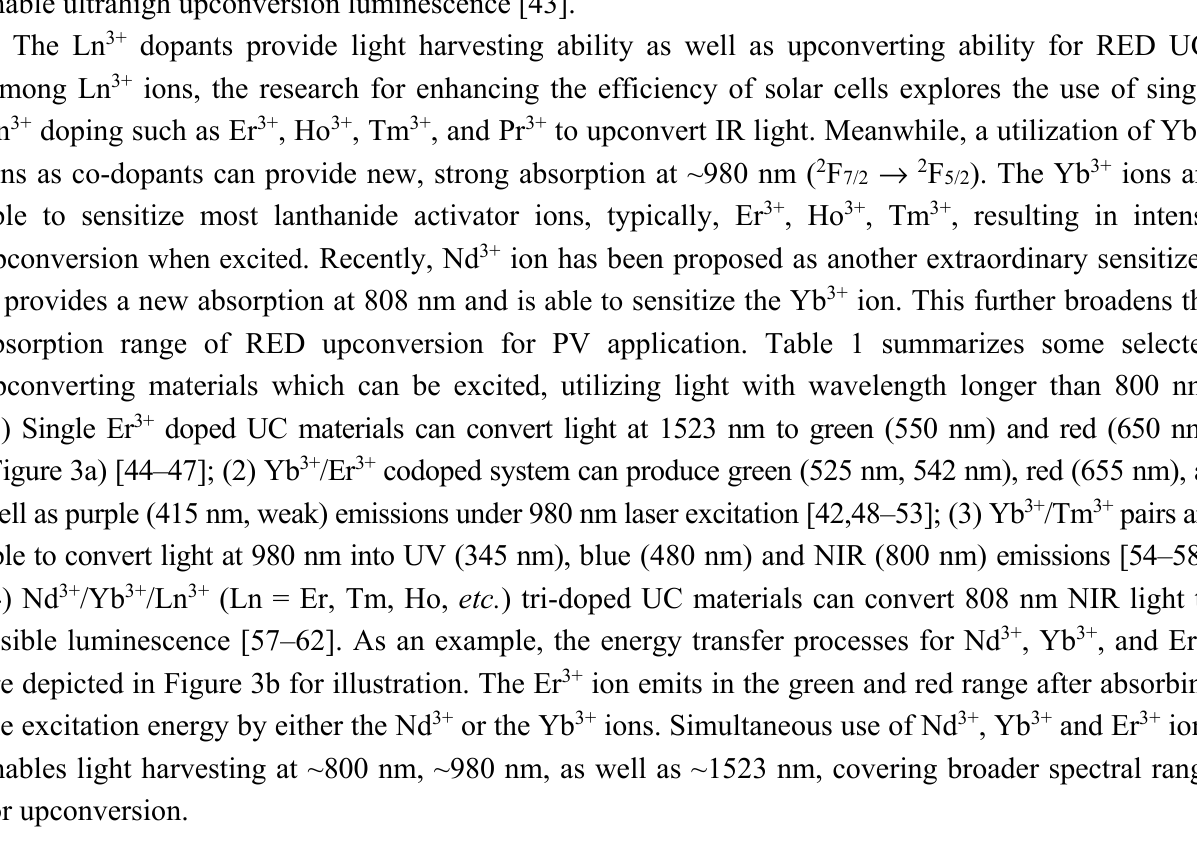
Table 1. Some selected upconverters excitable with wavelength longer than 800